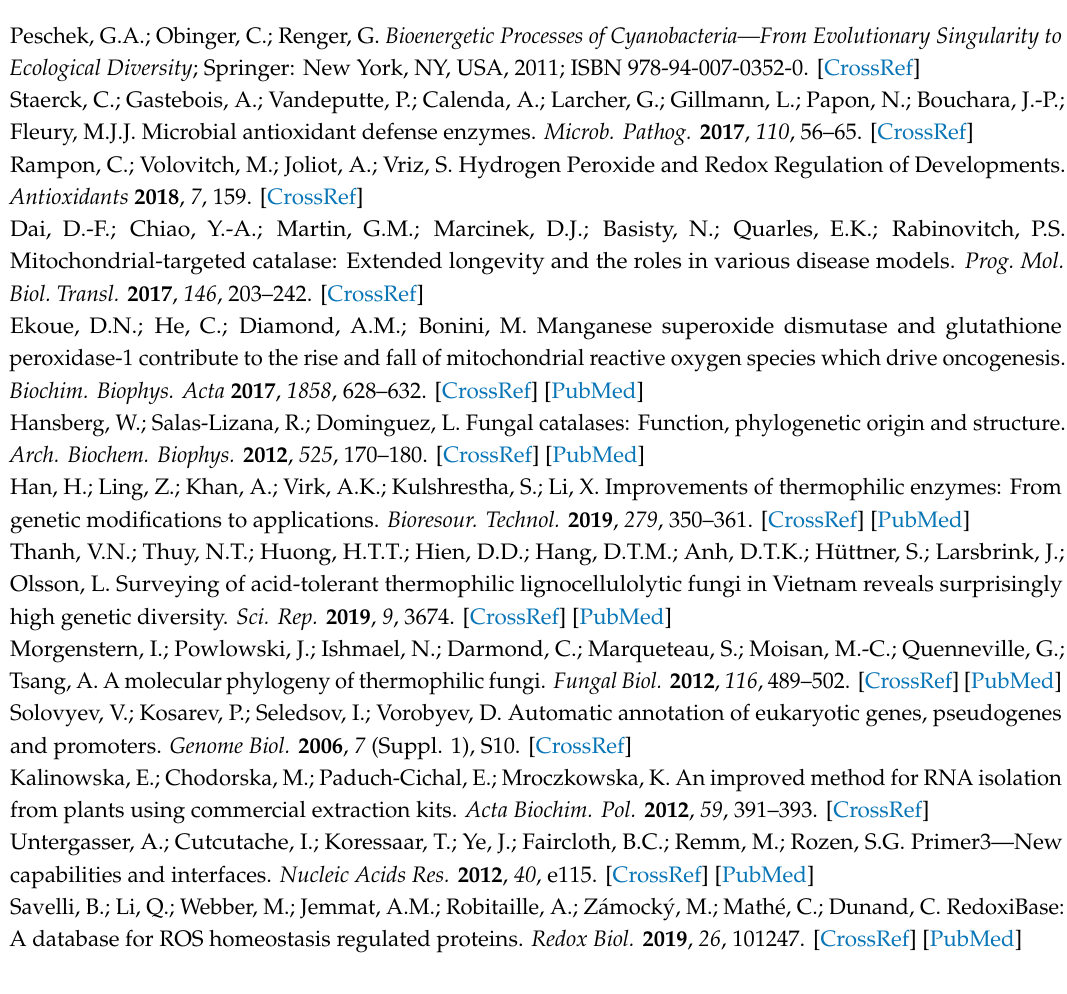
Figure S1. Main features of the newly sequenced genome of Chaetomium thermophilum var. dissitum . Figure S2. Multiple sequence alignment of CuZnSOD. Figure S3. Multiple sequence alignment of FeMnSOD. Figure S4. Multiple sequence alignment of heme catalases. Table S1. Sequences of DNA primers used for PCR analyses. Table S2. Sequences of CuZnSOD used for phylogenetic reconstruction with their accession numbers and taxonomic origin. Table S3. Sequences of FeMnSOD used for phylogenetic reconstruction with their accession numbers and taxonomic origin. Table S4. Sequences of heme catalases used for phylogenetic reconstruction with their accession numbers and taxonomic